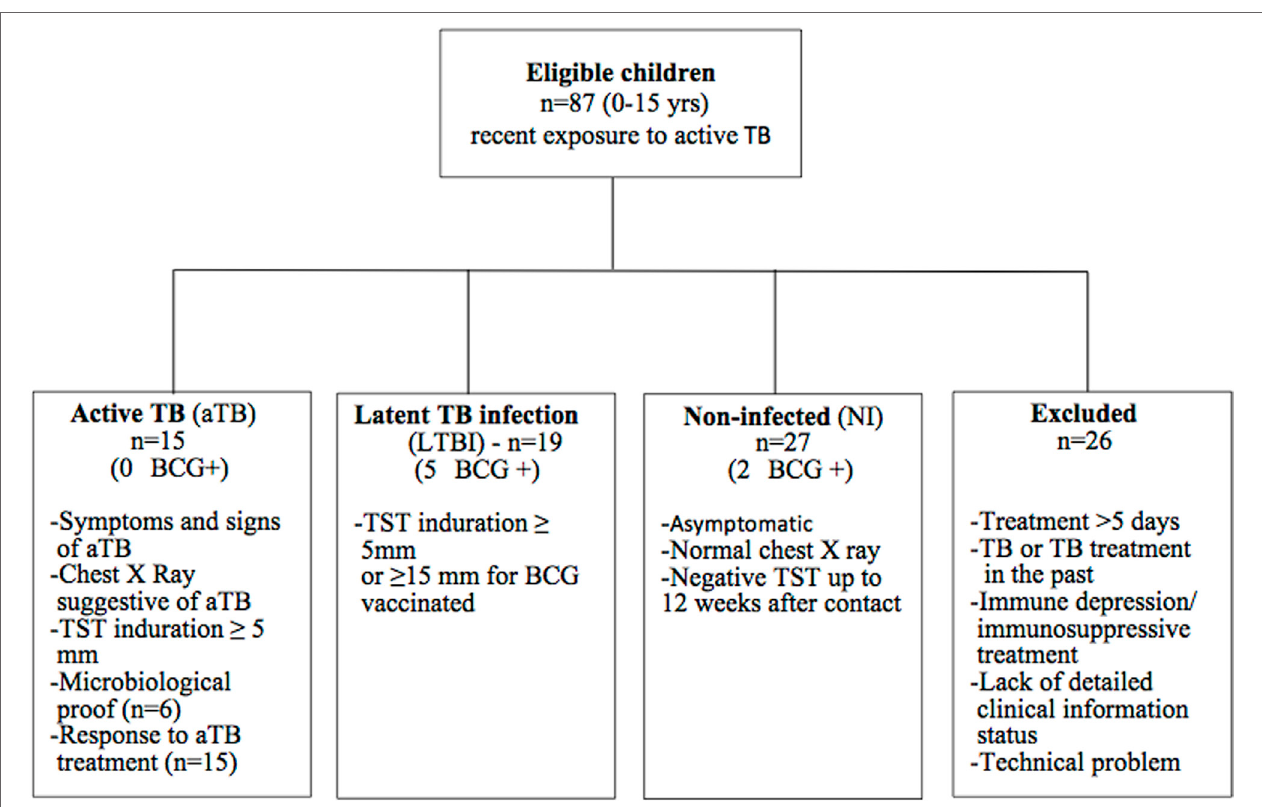
FigUre 1 | Flowchart of inclusion. Eighty-seven eligible children were prospectively enrolled in the study. Using strict criteria as defined in the Figure, they were retrospectively classified as NI, LTBI, or aTB. Twenty-six children were excluded from the final analysis for reasons explained in the